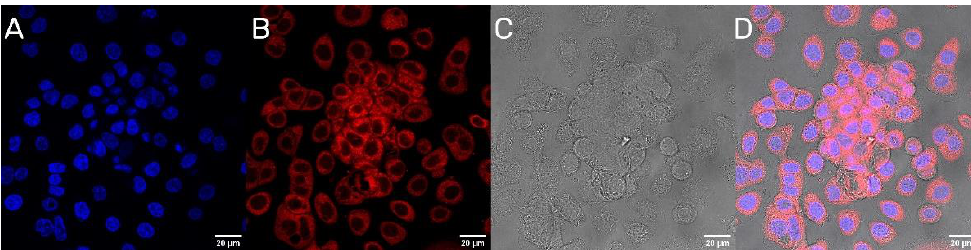
Figure 6. Visualization of the cellular uptake of Rhod6G loaded PLGA-PEG2000 nanoparticles by AsPC-1 pancreatic cell lines. ( A ). DAPI ( B ). Rhod6G fluorescence signal ( C ). transmitted light and ( D ). the merged image of the cells was observed after 2 h of incubation with labeled particles. Scale bar = 20 µm.